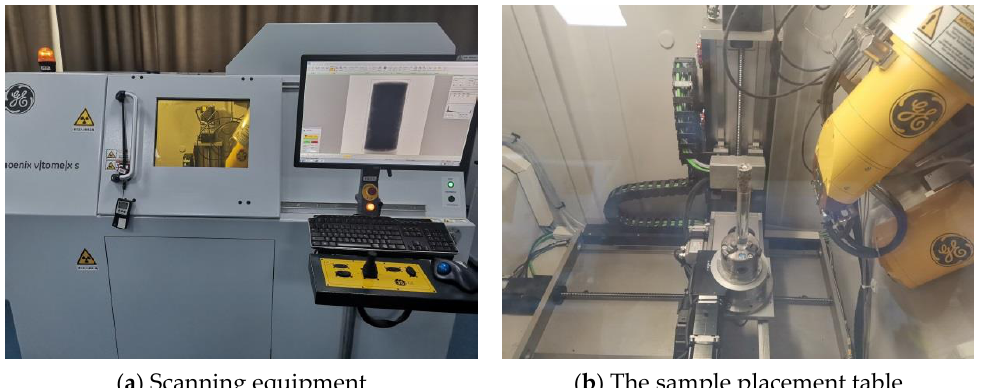
Figure 2. CT scanning equipment.